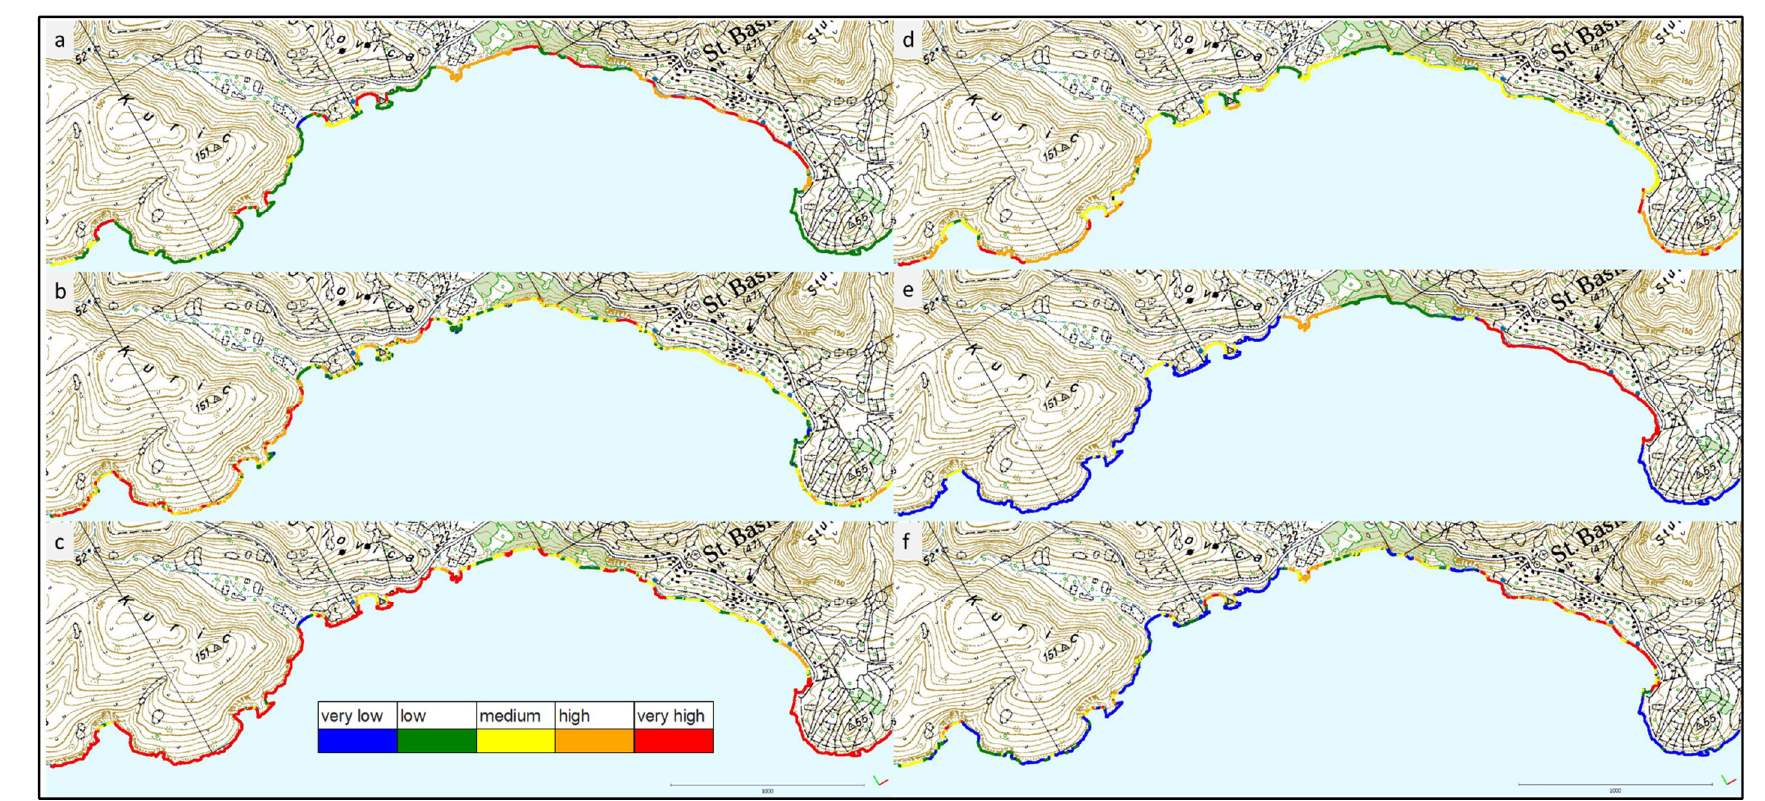
Figure 8. Relative coastal vulnerability value associated with the considered parameters: ( a ) Geological fabric; ( b ) Coastal slope; ( c ) Emerged beach width; ( d ) Significant wave height; ( e ) Land use; and ( f ) total CVI index (f).